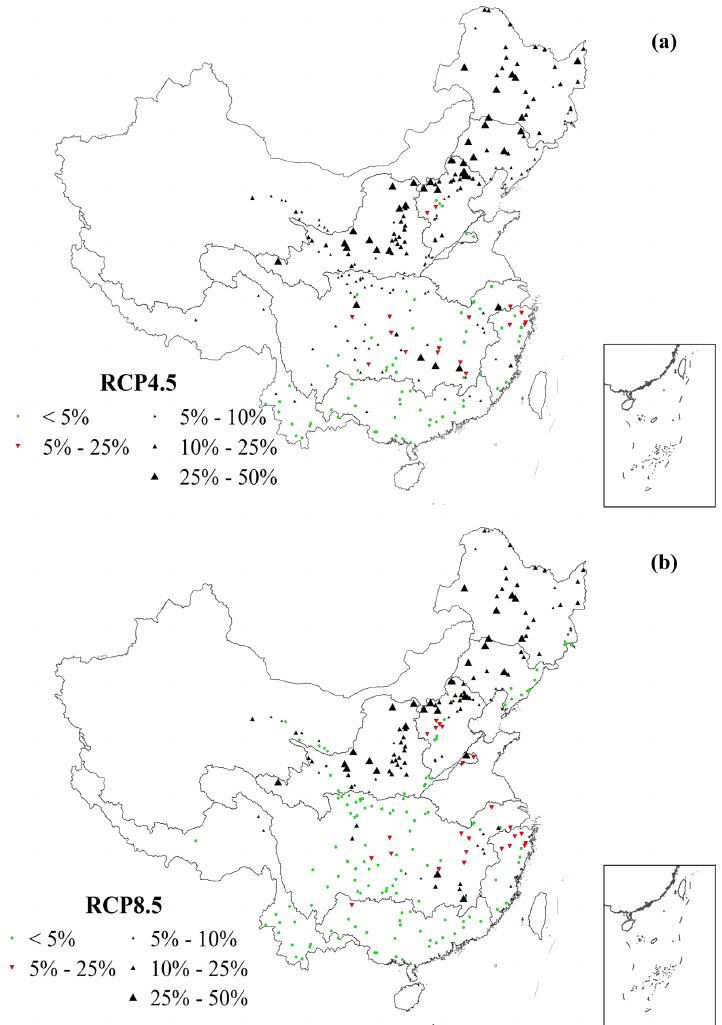
Figure 9. Contribution of snow ratio variance to change in mean annual runoff under projected future climate. (a) RCP4.5 and (b)